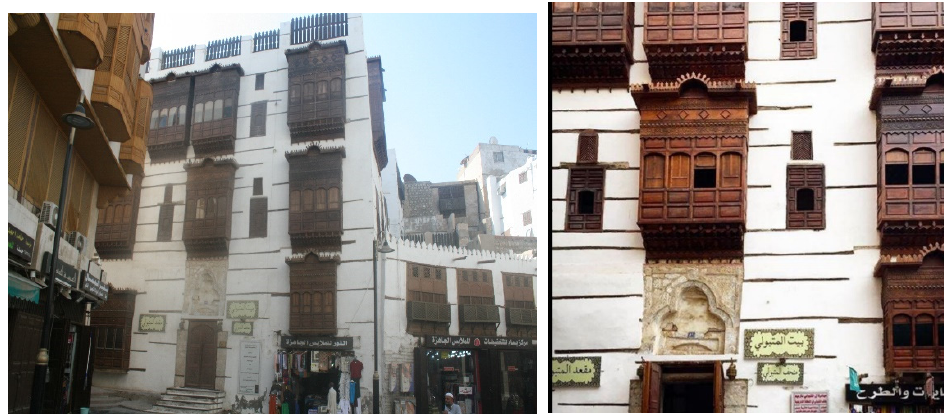
Figure 3. Matbouli Museum House in Historic Jeddah.